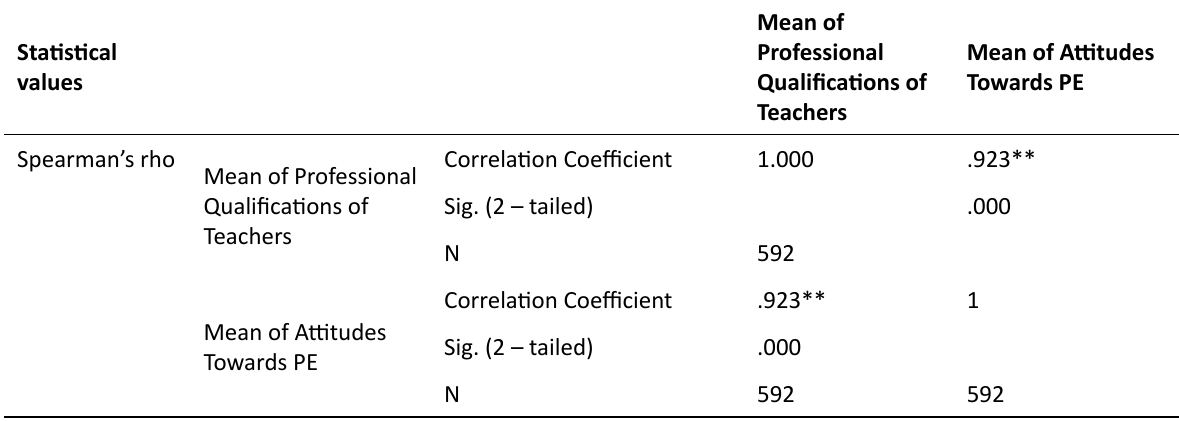
** Correlation is significant at the 0.01 level